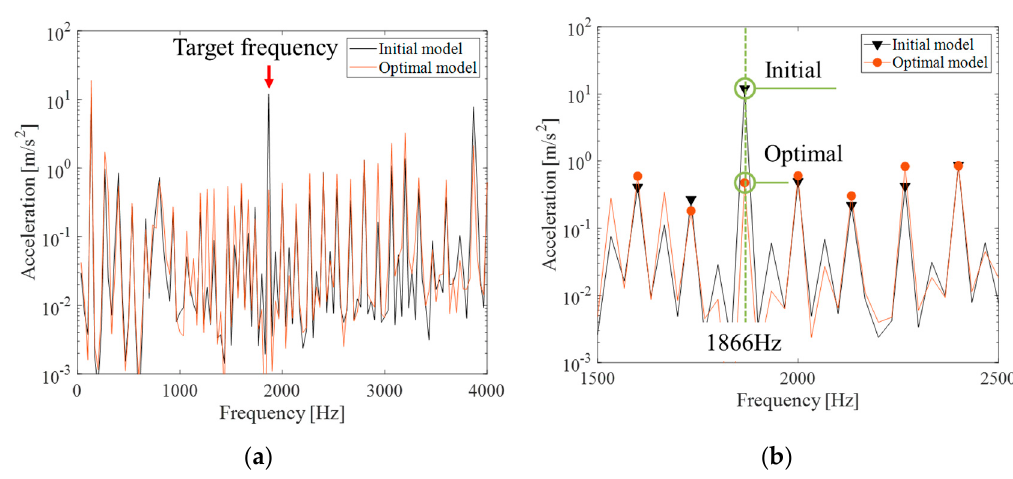
Figure 11. Comparison of acceleration response of Circular shape housing design ( a ) entire frequency range ( b ) narrow frequency range.